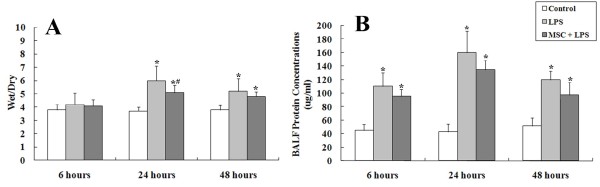
(A) Injection of UC-MSCs reduced pulmonary edema induced by LPS. Pulmonary edema was measured as the wet-dry ratio. (B): BALF protein concentration significantly increased after LPS injection and reached its peak at 24 h, while UC-MSCs caused a non-satistically significant decrease in the protein concentration. (*, p < 0.05 compared with healthy controls; #, p < 0.05 comparing LPS plus UC-MSCs with LPS alone.).